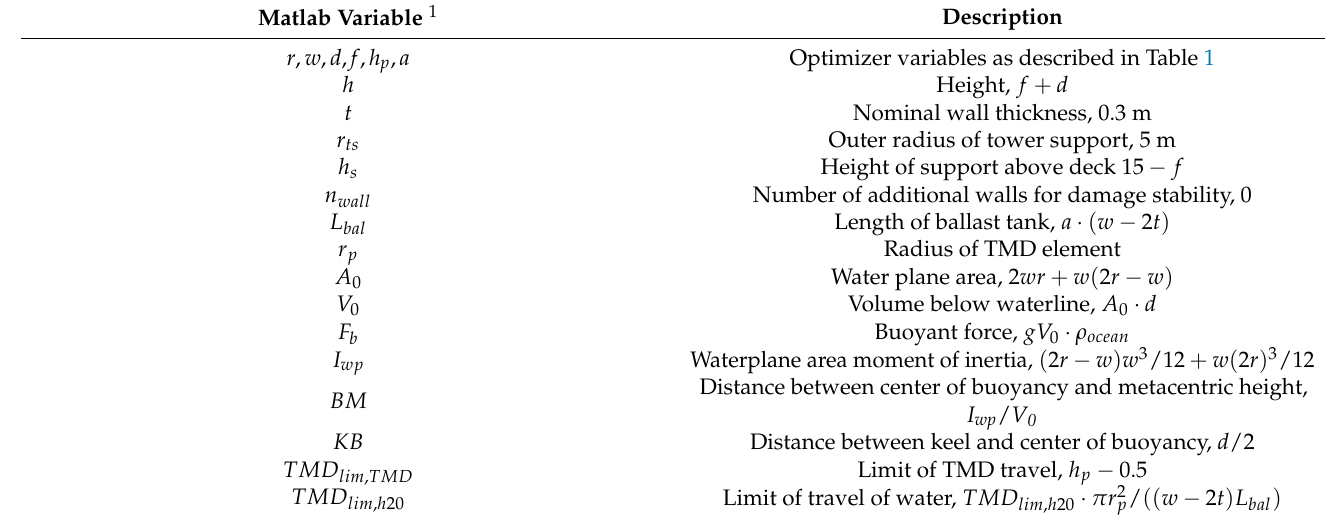
Table 2. HDF inputs.